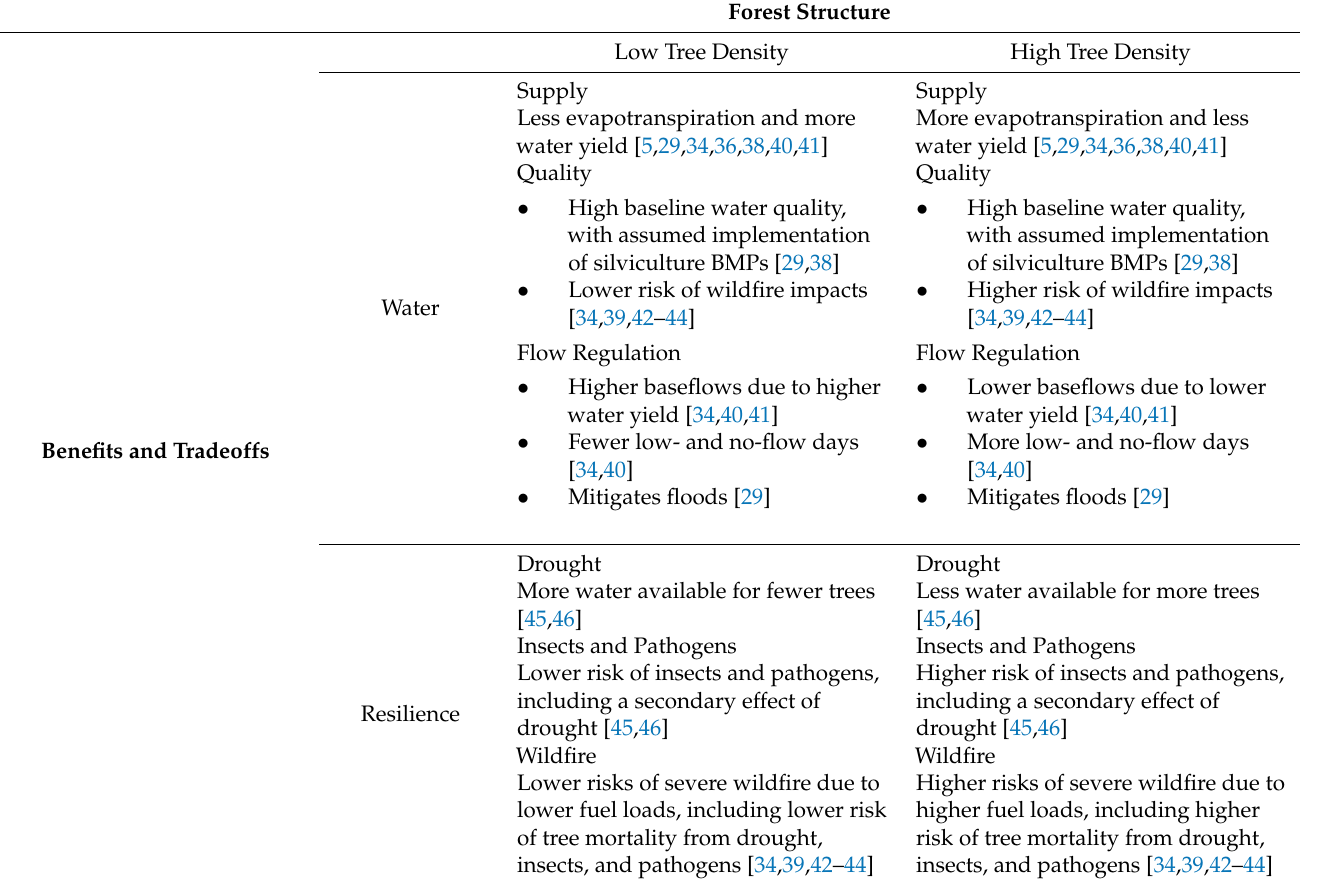
Forest Structure